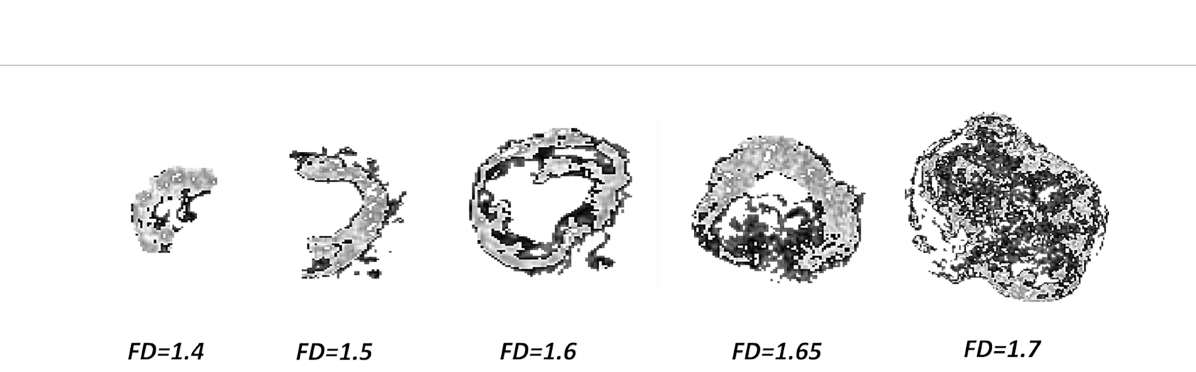
FIGURE 4 | Probability of 5yDFS to varying of the maxFD 30 – 50 extracted from the T2-w staging MR images in the case of the two treatment regimens. 5yDFS, 5- year disease-free survival; T2-w, T2-weighted.